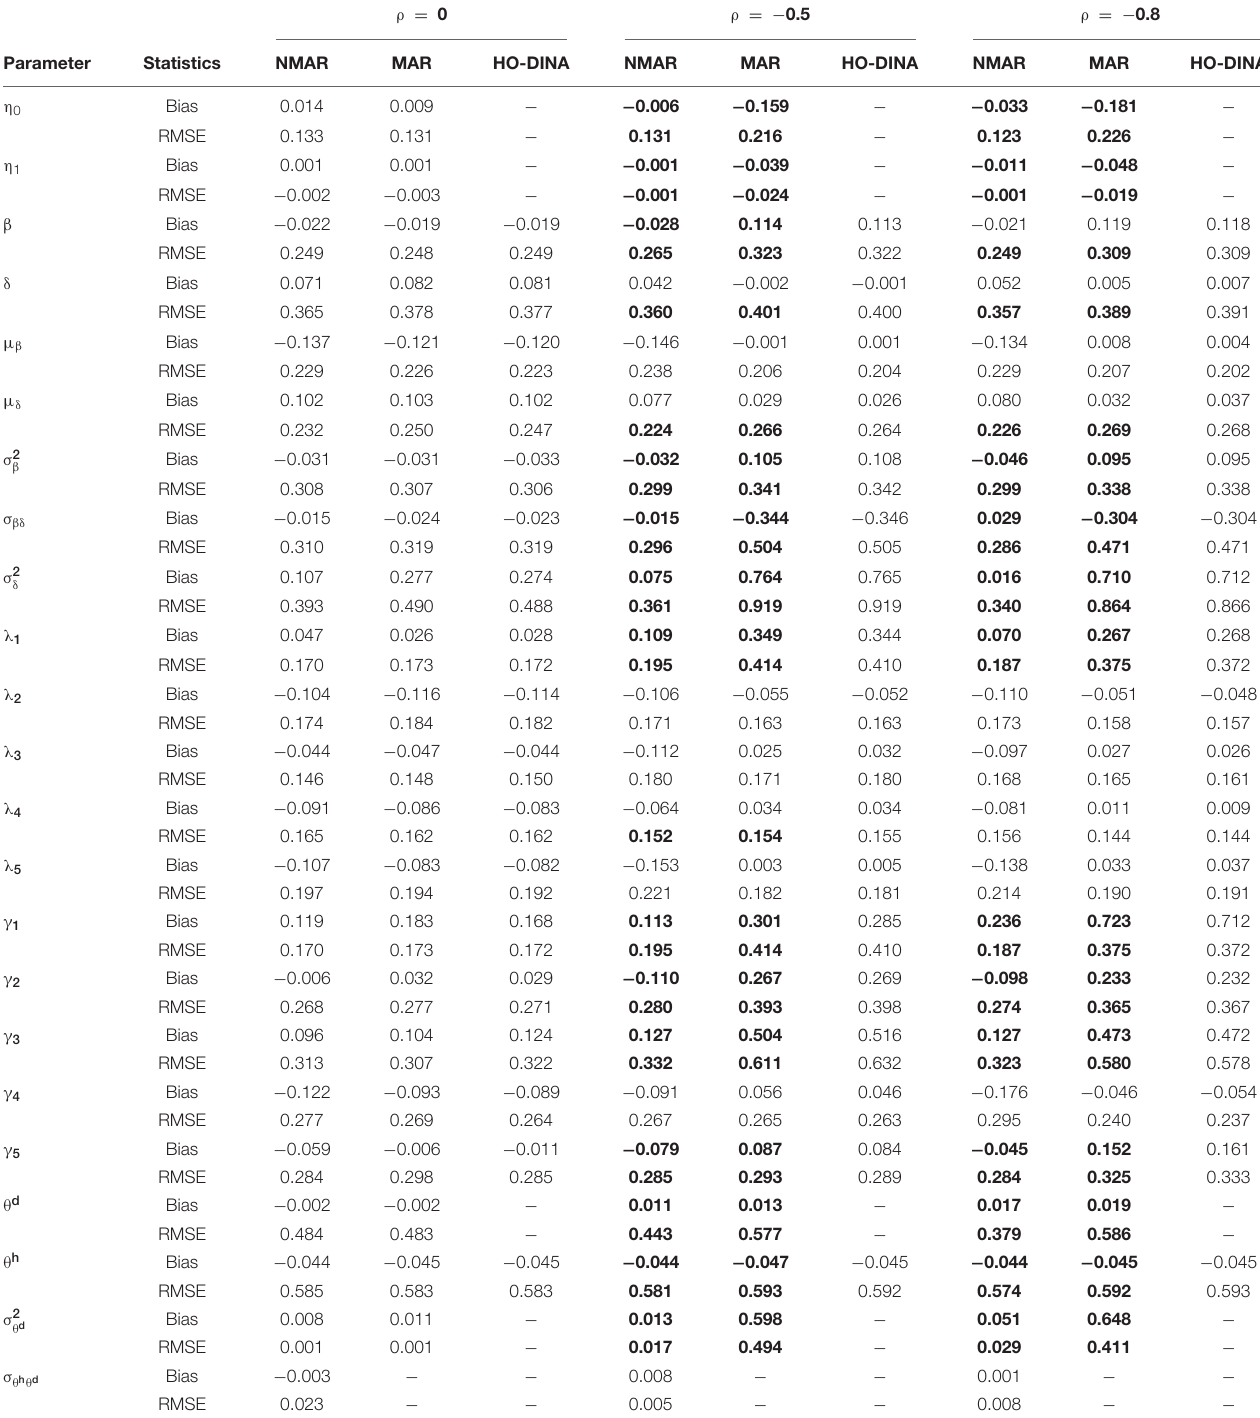
TABLE 4 | Bias and RMSE of parameter estimates of three models with medium dropping-out proportion under different correlations between θ h i and θ d i in simulation study III. ρ = 0 ρ = − 0.5 ρ = −